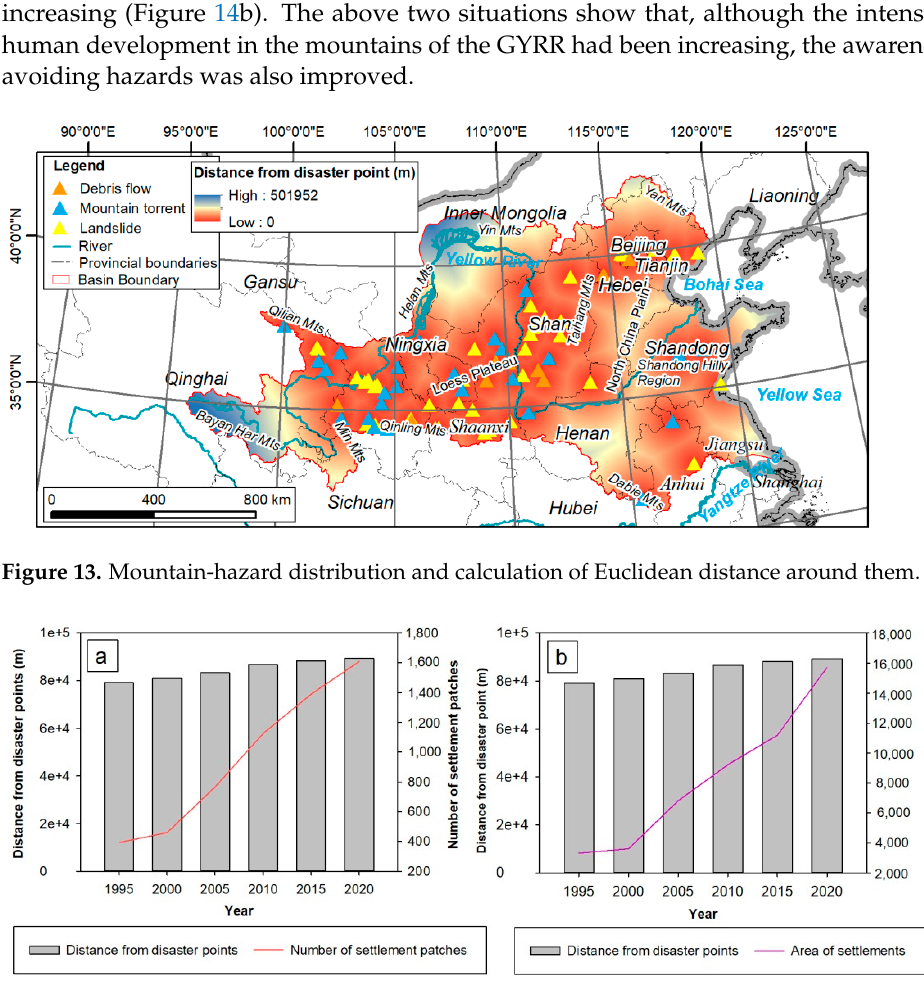
Figure 14. Relationship between hazard points and settlements. ( a ) Distance from hazard points and number of settlement patches; ( b ) distance from hazard points and area of settlements.